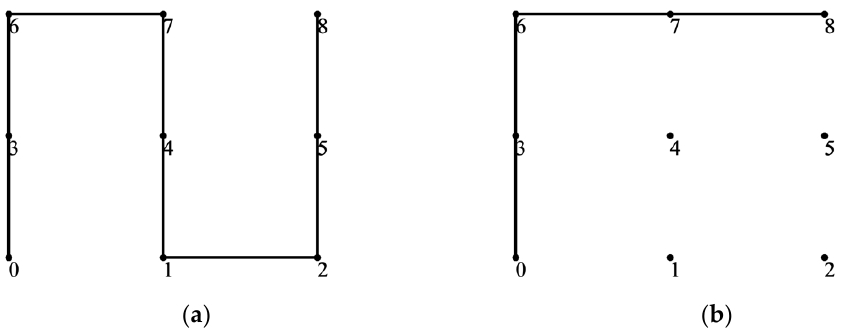
Figure 6. Example paths between nodes 0 and 8: ( a ) Path [0,3,6,7,4,1,2,5,8]; ( b ) Path [0,3,6,7,8].